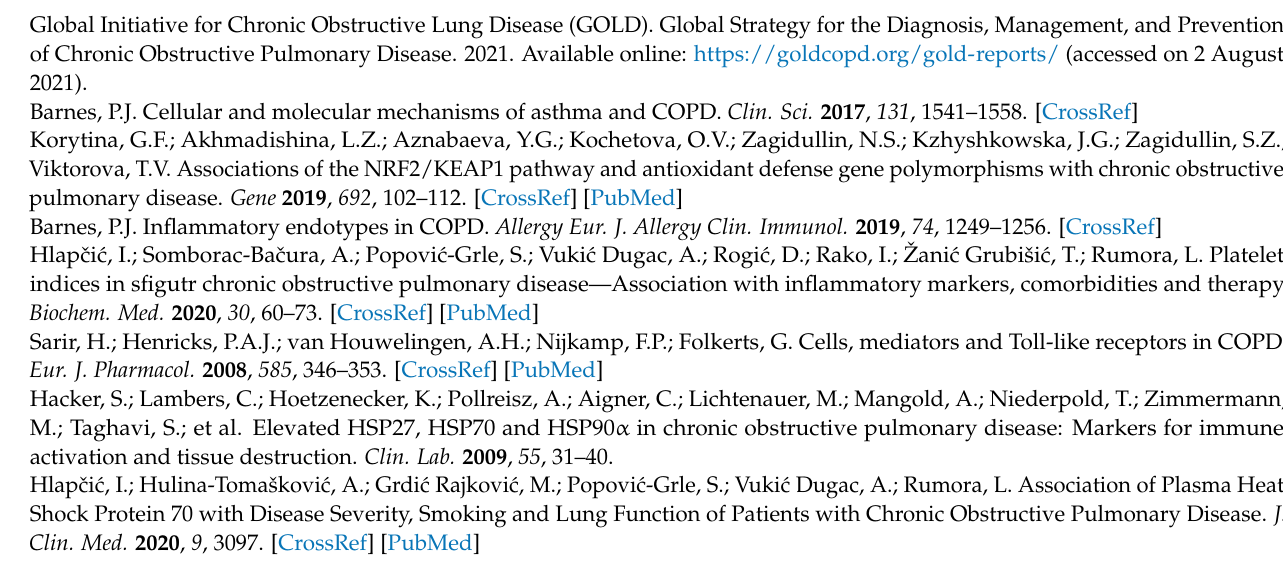
Table S2: Association of TLR4 polymorphisms with TLR4 expression; Table S3: Association of HSP70, TLR2 and TLR4 polymorphisms with plasma Hsp70 concentrations; Table S4: Association analysis of TLR4 haplotypes with COPD